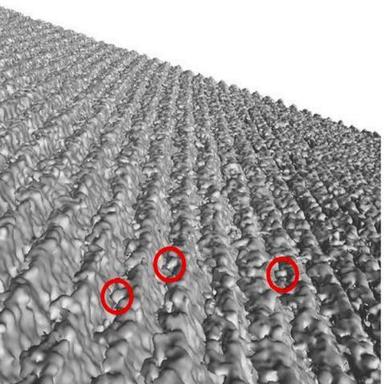
Close up of an SLS surface in XCT, showing the unfused powder representation (examples circled in red).